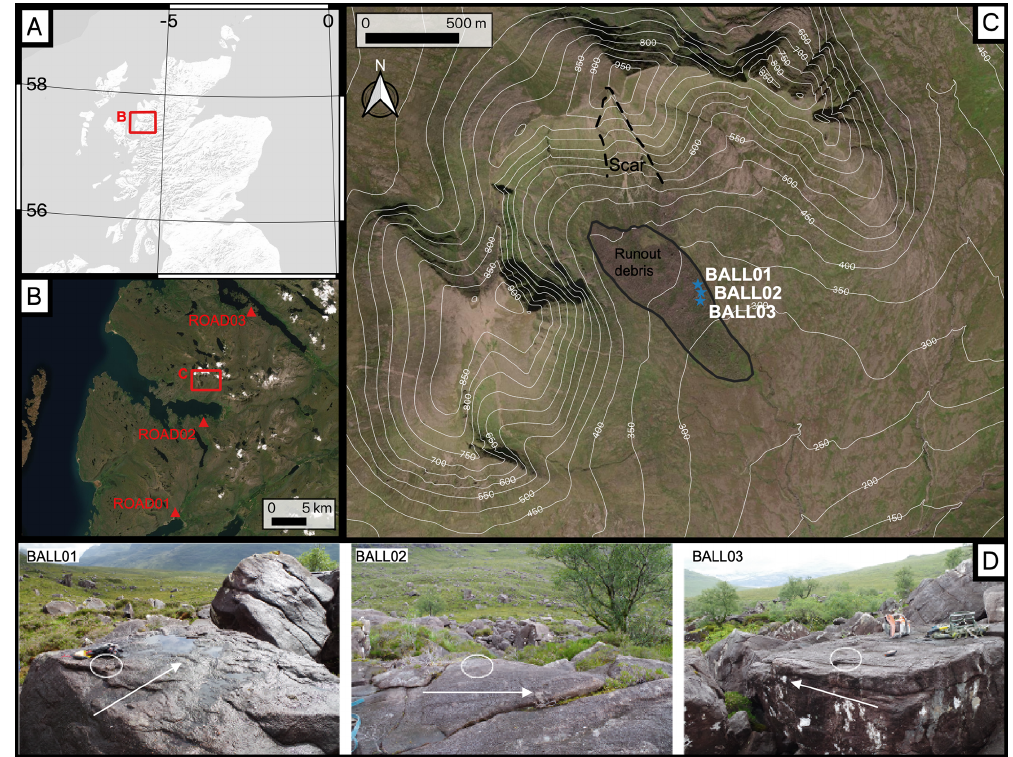
Figure 1. Location of the Beinn Alligin rock avalanche (57 ◦ 35 (cid:48) N, 05 ◦ 34 (cid:48) W) and road-cut sections in NW Scotland (a, b) . Sample sites on the rock avalanche deposit (c) . Photographs of flat-topped boulders sampled and the general rock avalanche flow direction (white arrow) for BALL01, BALL02 and BALL03 (d) . The backgrounds used are ESRI World Terrain Base (a) and ESRI World Imagery (b, c) . Contains OS data ©Crown copyright and database right (2021). Scar and run-out debris locations mapped in (c) follow Ballantyne and Stone (2004).